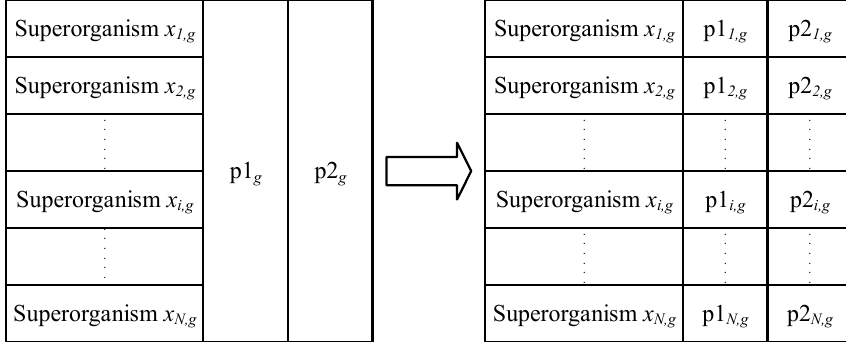
Figure 5. Parameter self-adaptation encoding.